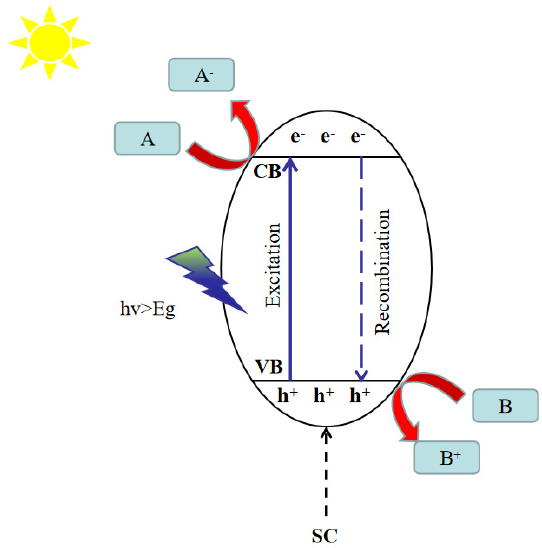
Figure 1. The mechanism of the photocatalytic process.